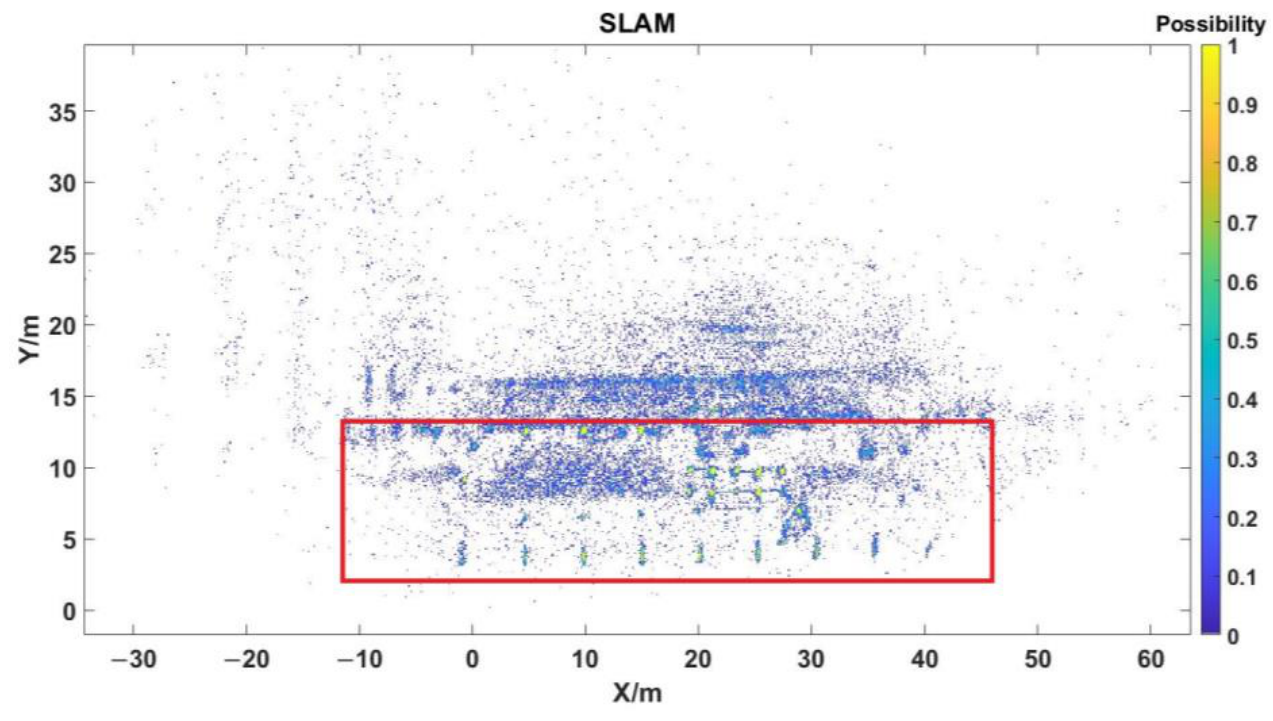
Figure 11. SLAM grid map with all radar false detections.